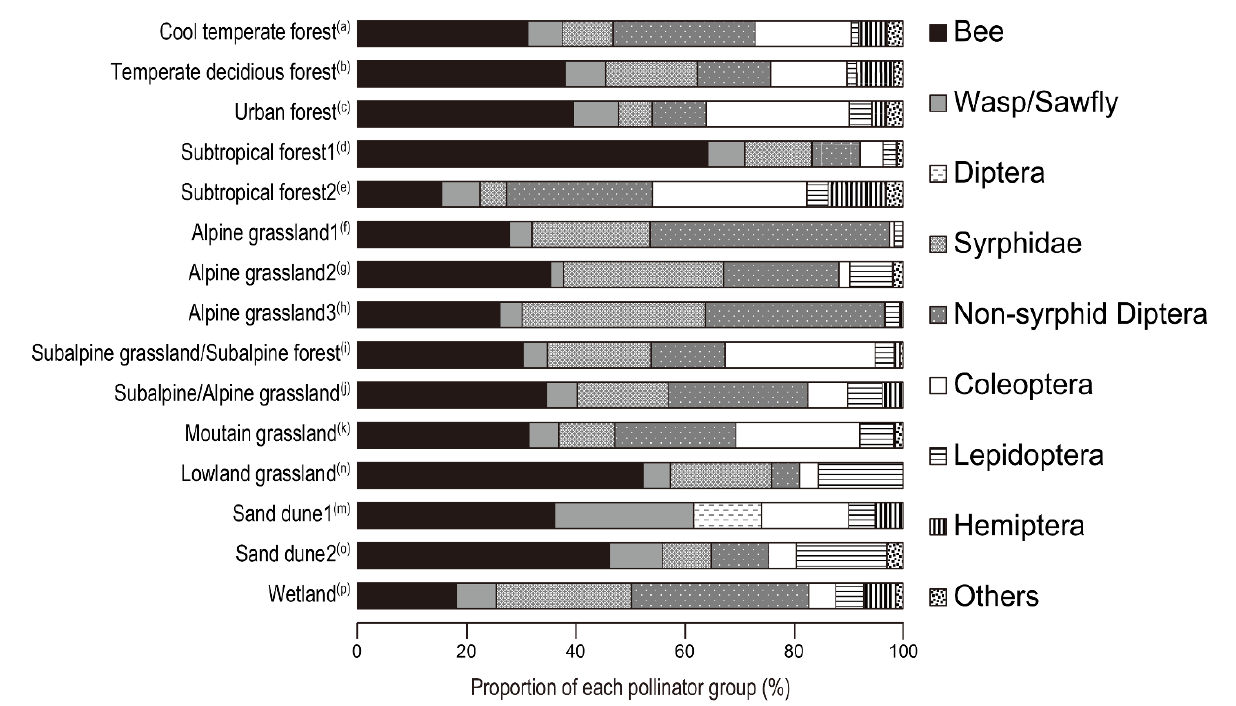
F IGURE 2. Relative abundance of different types flower visitors observed in various habitat types in East Asia. The study sites and references are as follows: (a) Ashu (Japan), Kato et al. (1990); (b) Kibune (Japan), Inoue et al. (1990); (c) Kyoto (Japan), Kakutani et al. (1990); (d) Heishiding Nature Reserve (China), Zhang & He (2017); (e) Amami Island (Japan), Kato (2000); (f) Mt. Tateyama (Japan), Ishii et al. (2019); (g) Hengduan Mountains (China), Fang & Huang (2012); (h) Taisetsu Mountains (Japan), Mizunaga & Kudo (2017); (i) Mt. Kushigata (Japan), Kato et al. (1993); (j) Mt. Yulong (China), Zhao et al. (2016); (k) Mt. Yufu (Japan), Yamazaki & Kato 2003; (n) Nishitani (Japan), Nikkeshi et al. (2015); (m) Hakoishi (Japan), Inoue & Endo (2006b); (o) Honshu and Izu Islands (Japan), Hiraiwa & Ushimaru (2017); (p) Nakaikemi marsh (Japan), Kato & Miura (1996). Notes: Syrphidae and Non-syrphid Diptera are not distinguished in Sand dune1, Hemiptera may be included in the Others category for Alpine grassland1, and ants may be included in the Wasp/Sawfly category in data for the Subalpine/Alpine